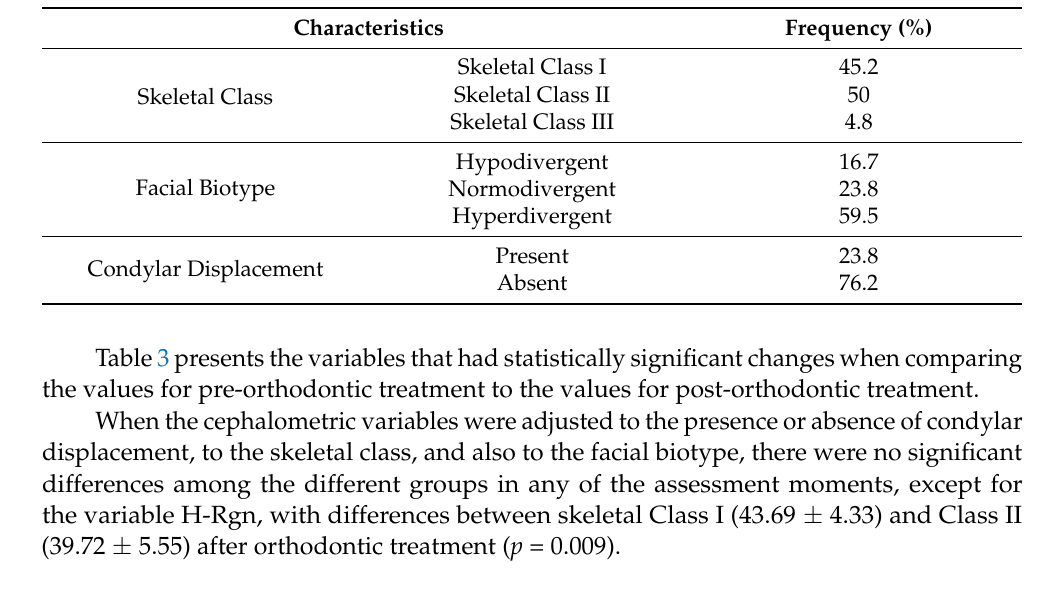
Table 2. Sample characterization regarding skeletal class, facial biotype, and condylar displacement before orthodontic treatment ( n =